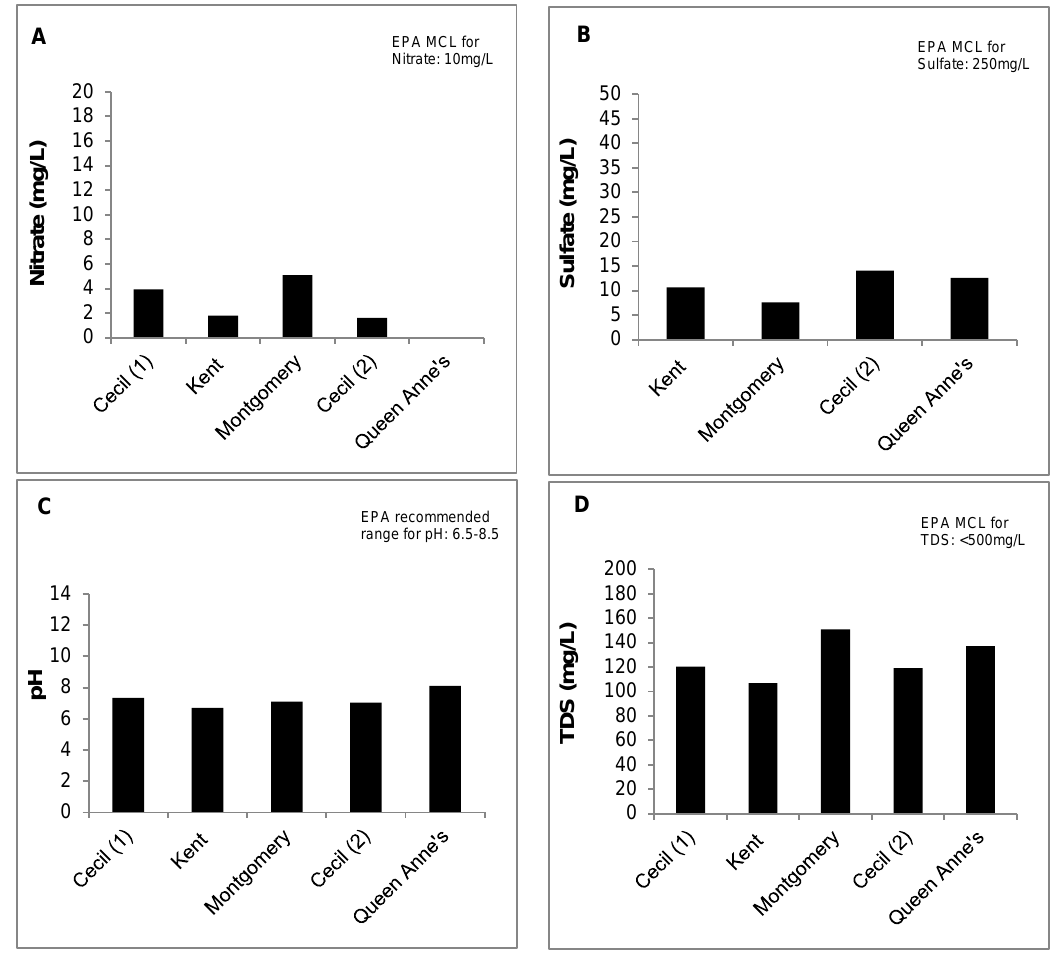
Figure 4. Mean levels of nitrate (Panel A ), sulfate (Panel B ), pH (Panel C ) and total dissolved solids (TDS) (Panel D ) detected in tested private wells by county [38]. MCL — maximum contaminant level. Kent County had the highest percentage of wells that tested positive for fecal indicator bacteria, with 52.4% of wells testing positive for at least one type of indicator bacteria (Figure 5). E. coli was detected in wells sampled in every county with the exception of Cecil County. Enterococcus was detected in samples from all counties; however, it was not detected during the first clinic conducted in Cecil County. Figure 5 . Percentage of tested private wells that were positive for fecal indicator bacteria by county.